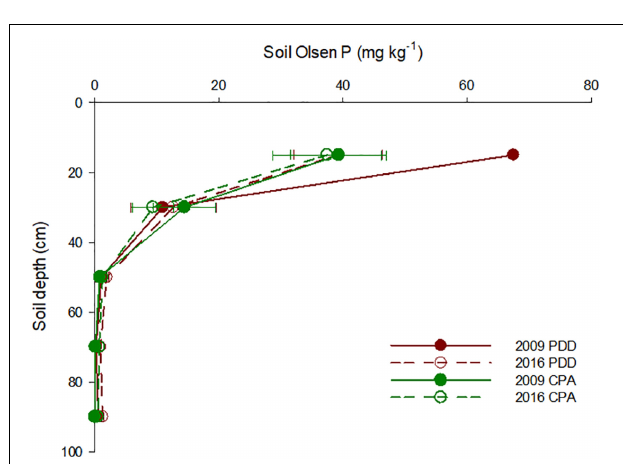
FIGURE 3 | Soil Olsen P concentrations in the profile of the soil managed under continuous fertilizer P additions ( CPA ) and soil P draw-down ( PDD ) between 2009 and 2016. The horizontal T-bars are standard errors ( n =